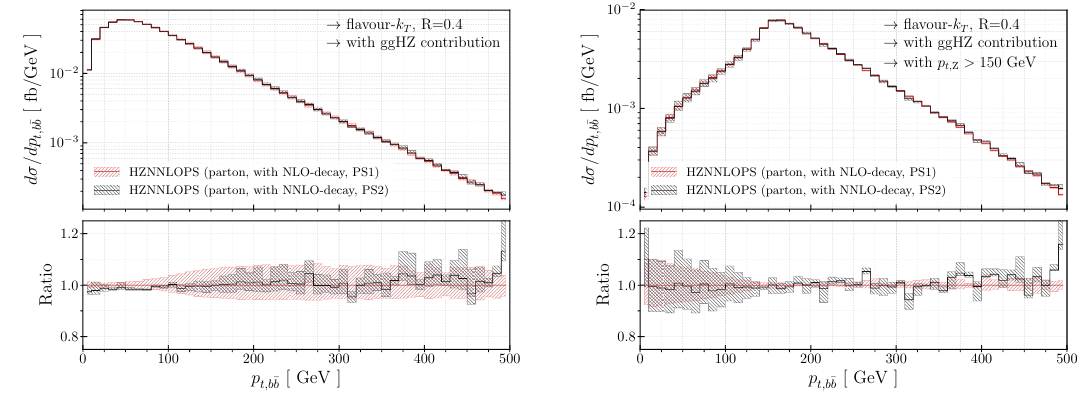
Figure 3 . As (cid:12)gure 2 but for the transverse momentum of the two b -jets used for the Higgs reconstruction, p , without (left) and with (right) a p t;Z cut of 150 t;b (cid:22) b